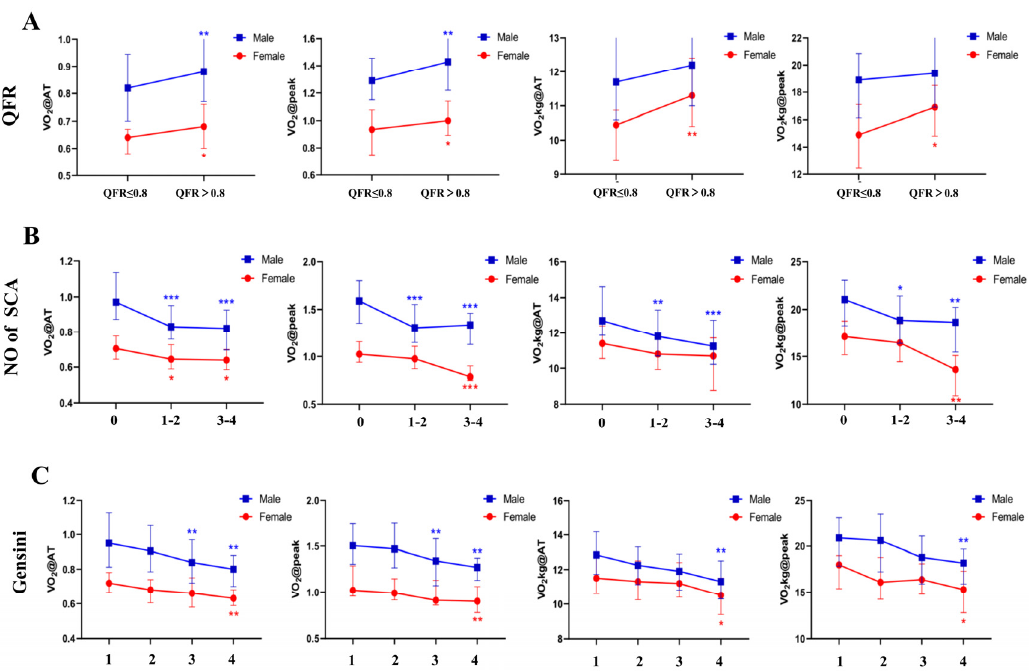
Figure 1. VO 2 @peak, VO 2 @AT, VO 2 kg@peak and VO 2 kg@AT levels according to ( A ) quantitative